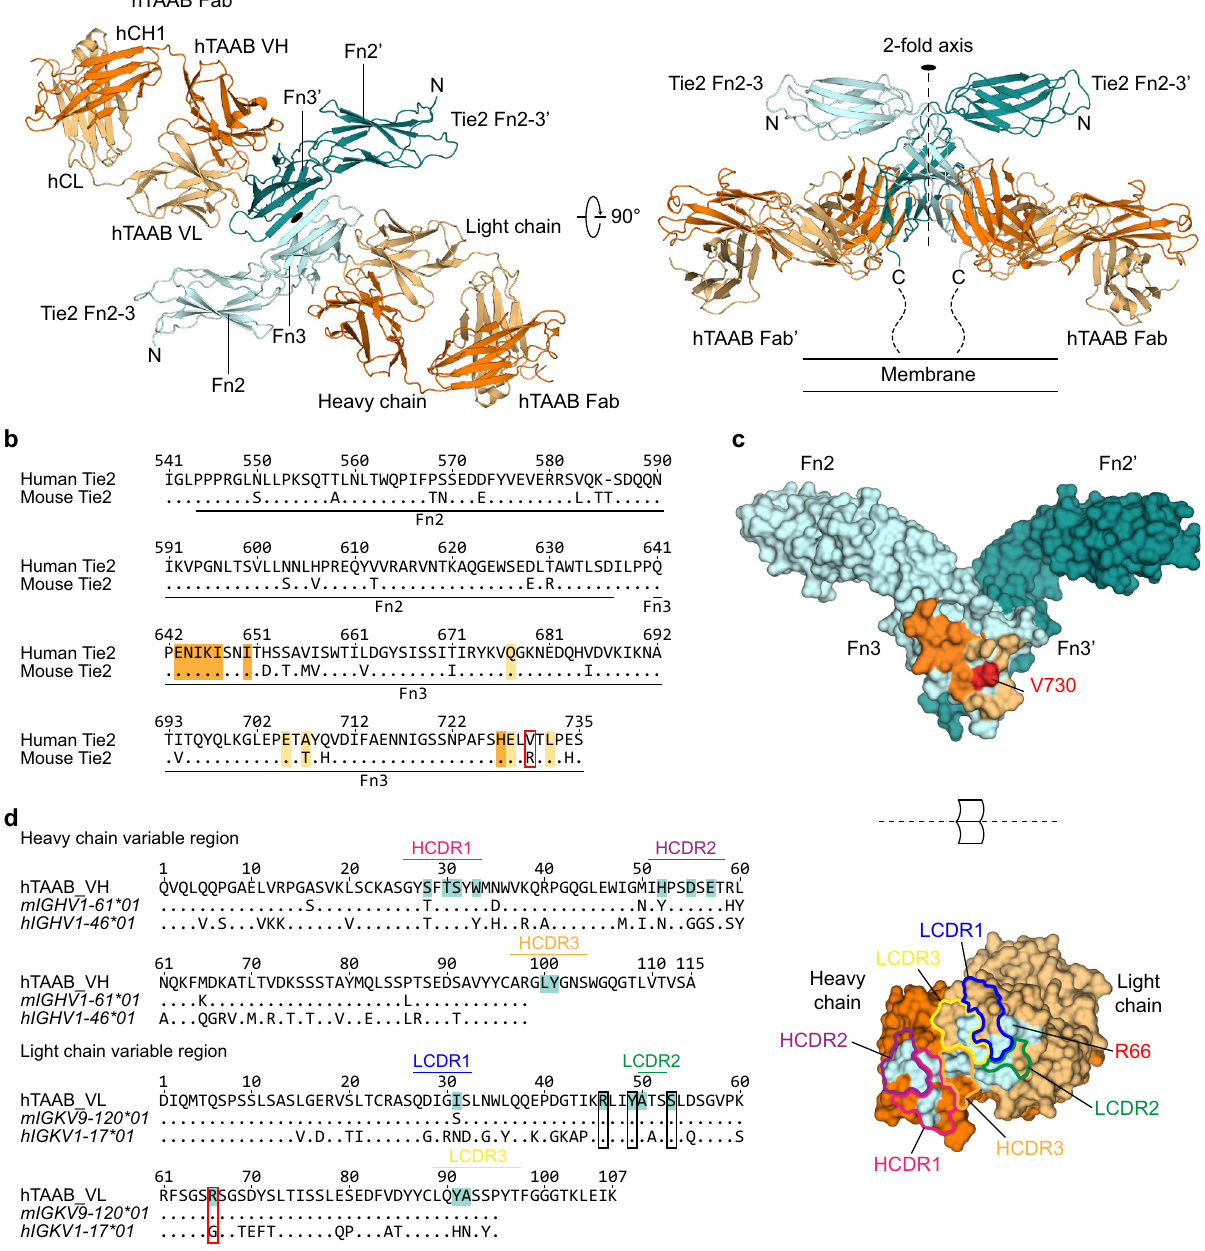
Fig. 2 Overall structure of hTAAB Fab in complex with Tie2 Fn2 – 3. a Overall structure of the 2:2 hTie2 Fn2 – 3/chimeric hTAAB Fab complex. The 2-fold axis of the dimeric complex is indicated as a black ellipse. The heavy and light chains of chimeric hTAAB Fab are colored in dark and light orange, respectively. The hTie2 Fn2 – 3 dimer is colored in teal and cyan. b Sequence comparison of human and mouse Tie2 Fn2 – 3 domains. The dots in the mouse Tie2 sequence indicate residues that are identical to human Tie2. c The surface representations are open-book views showing the interacting interfaces of Tie2 Fn2 – 3 (top) and chimeric hTAAB Fab (bottom). The color scheme of hTie2 Fn2 – 3 and chimeric hTAAB Fab is identical to that in ( a ), but inverted for their respective binding surface. Six CDR loops of chimeric hTAAB Fab are indicated with different color lines (bottom). d Sequence comparison of the variable region of hTAAB heavy (top) and light (bottom) chains with closest human and mouse variable region germline genes. The dots in mouse and human germline sequences indicate the residues that are identical to hTAAB. b – d hTie2 residues that interact with the heavy and light chain of chimeric hTAAB Fab are colored dark and light orange, respectively, and V730, which interacts with both heavy and light chains, is highlighted in red ( b , c , top). The chimeric hTAAB Fab residues that interact with hTie2 Fn3 are colored cyan ( c , bottom, and d heavy domain (CH), variable light domain (VL), and constant (Supplementary Fig. 2c, d). light domain (CL) — adopted a typical Ig domain fold consisting These results indicate that hTAAB binding triggered no of a pair of β -sheets. All complementarity-determining regions conformational changes in the hTie2 homodimer. Four domains (CDRs) of the heavy chain (HCDR1, HCDR2, and HCDR3) and of chimeric hTAAB Fab — variable heavy domain (VH), constant light chain (LCDR1, LCDR2, and LCDR3) participated in contact